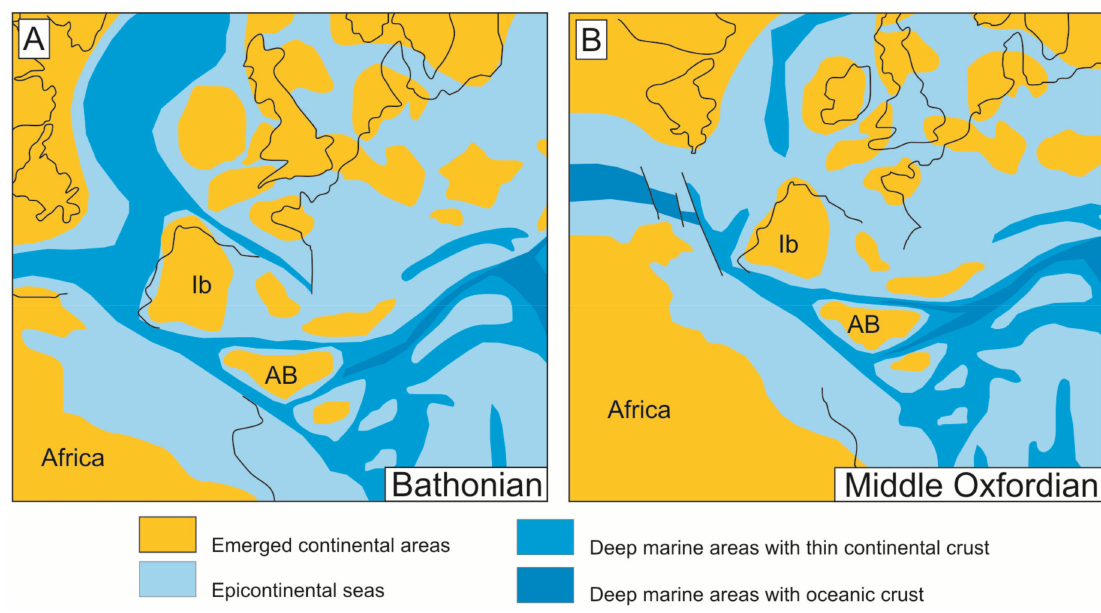
Figure 2. Paleogeographic reconstruction of the western part of the Tethys during the Bathonian ( A ) and the Middle Oxfordian ( B ). Ib: Iberian Massif and AB: Alboran